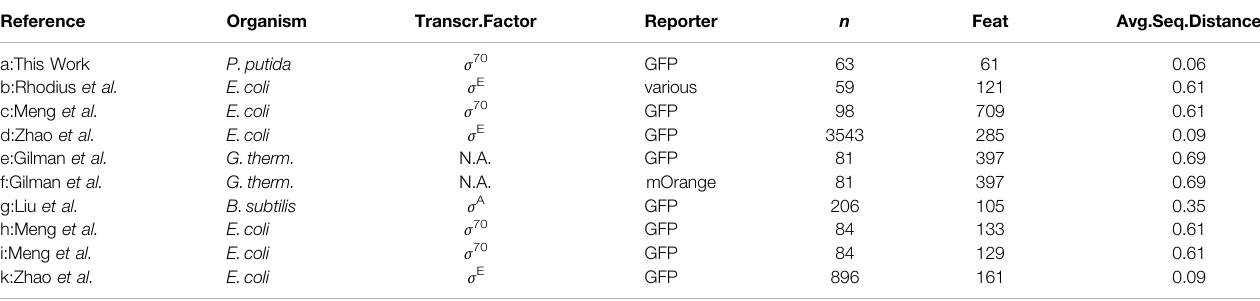
TABLE 3 | Details of the six published libraries used to compare estimation quality in response to the experimental design. The columns n represent total sample size, Feat. the size of the input vector, Avg.Seq.Distance the average distance of all sequences to a reference sequence, composed of the most common nucleotide at each position.Acomprehensivetablewithnumericalvaluesof Figure4 inthe SupplementaryData .Multipletranscriptionfactorsareresponsibleforgeneexpressioninthedata set of Gilman et al. (2019), hence is not applicable ( N.A.